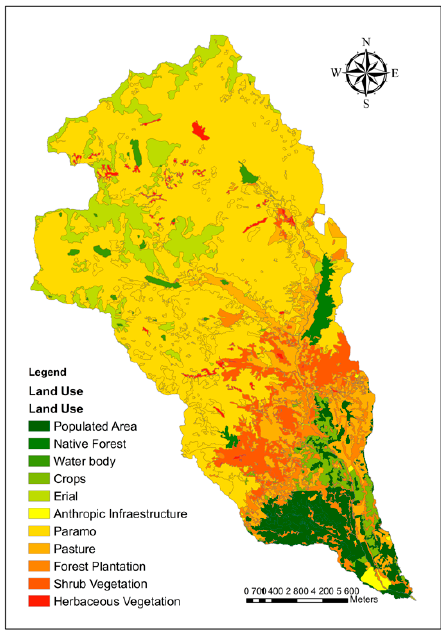
/ use distribution of the Mach á ngara Figure 2. Land cover/use distribution of the Machángara Basin. Figure 2. Land cover